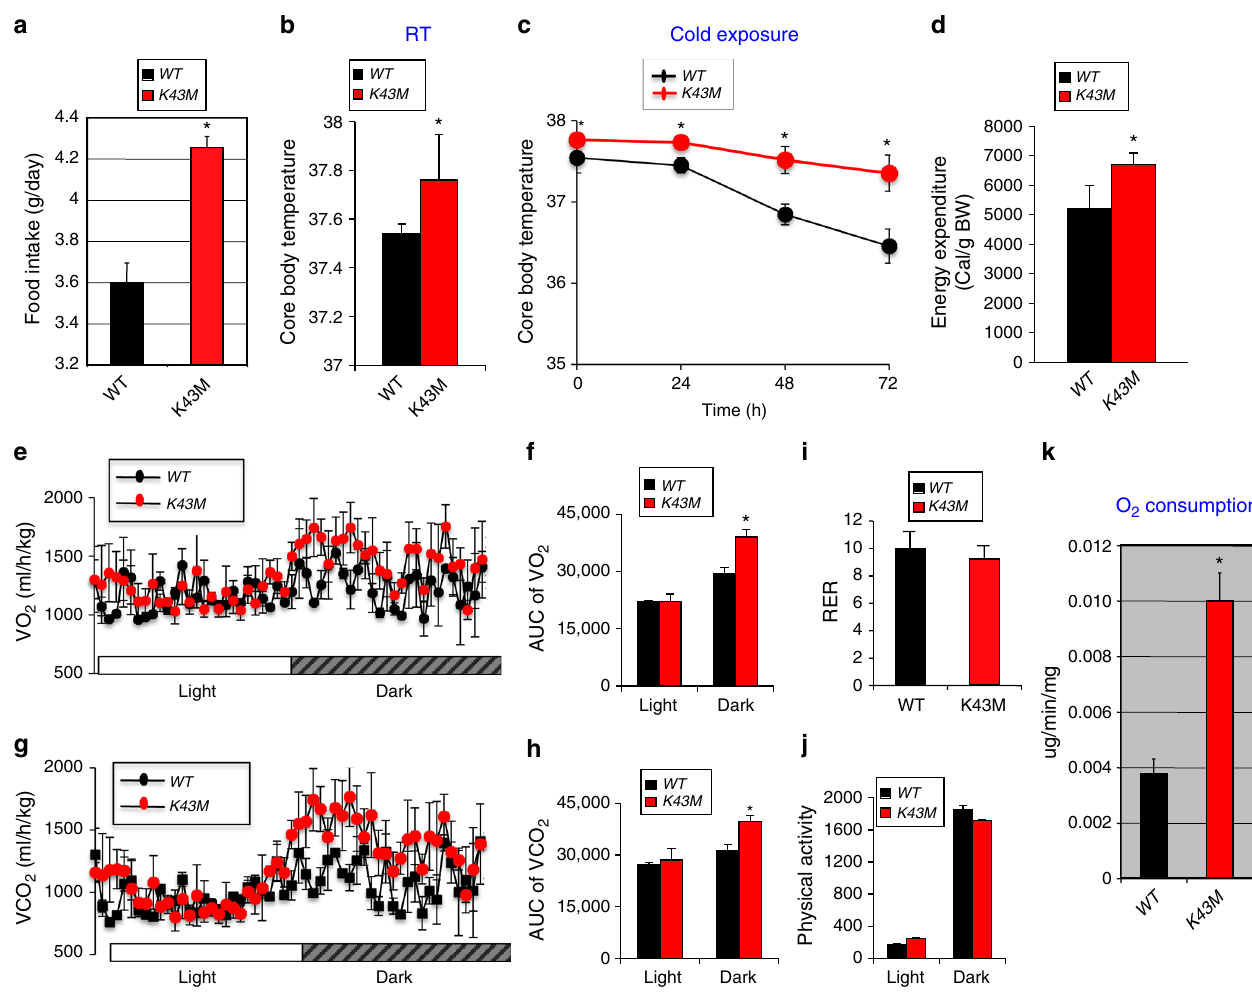
Fig. 3 Loss of CDK6 kinase activity in mice leads to increased food intake, body temperature, adaptability to cold exposure and energy expenditure. a Bar graphs demonstrating food intake of age-matched male WT and K43M mice at 18 weeks of age. b , c Core body temperature of male mice at room temperature ( b , RT) or at 4 °C ( c ) for up to 72 h ( n = 6 per group). d Energy expenditure (EE) was calculated based on the formula below: EE = (3.815 + 1.232 × RER) x VO 2 /lean mass (g). For a – d , data are expressed as mean ± S.E., * p < 0.05, vs WT , t -test. e – h , Oxygen consumption (VO 2 ) (e, f) and CO